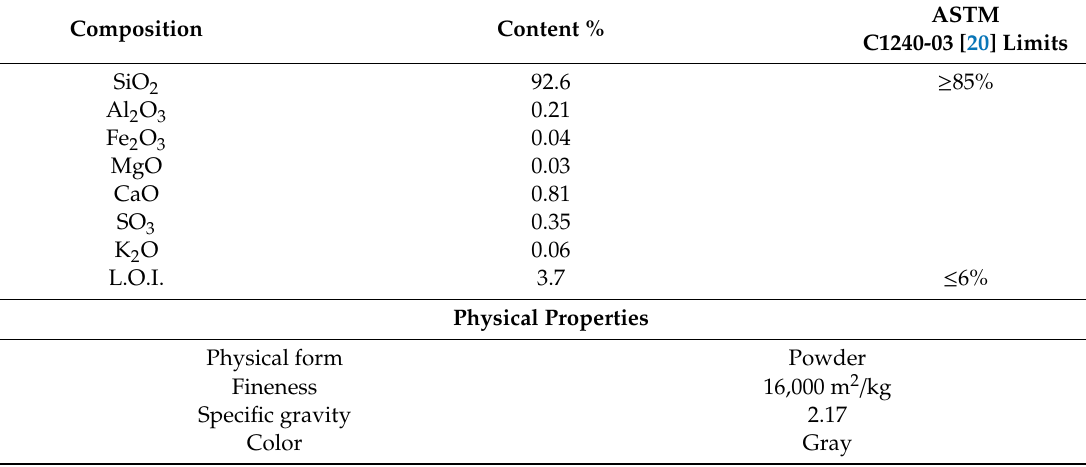
Table 3. Silica fume physical properties and chemical composition.